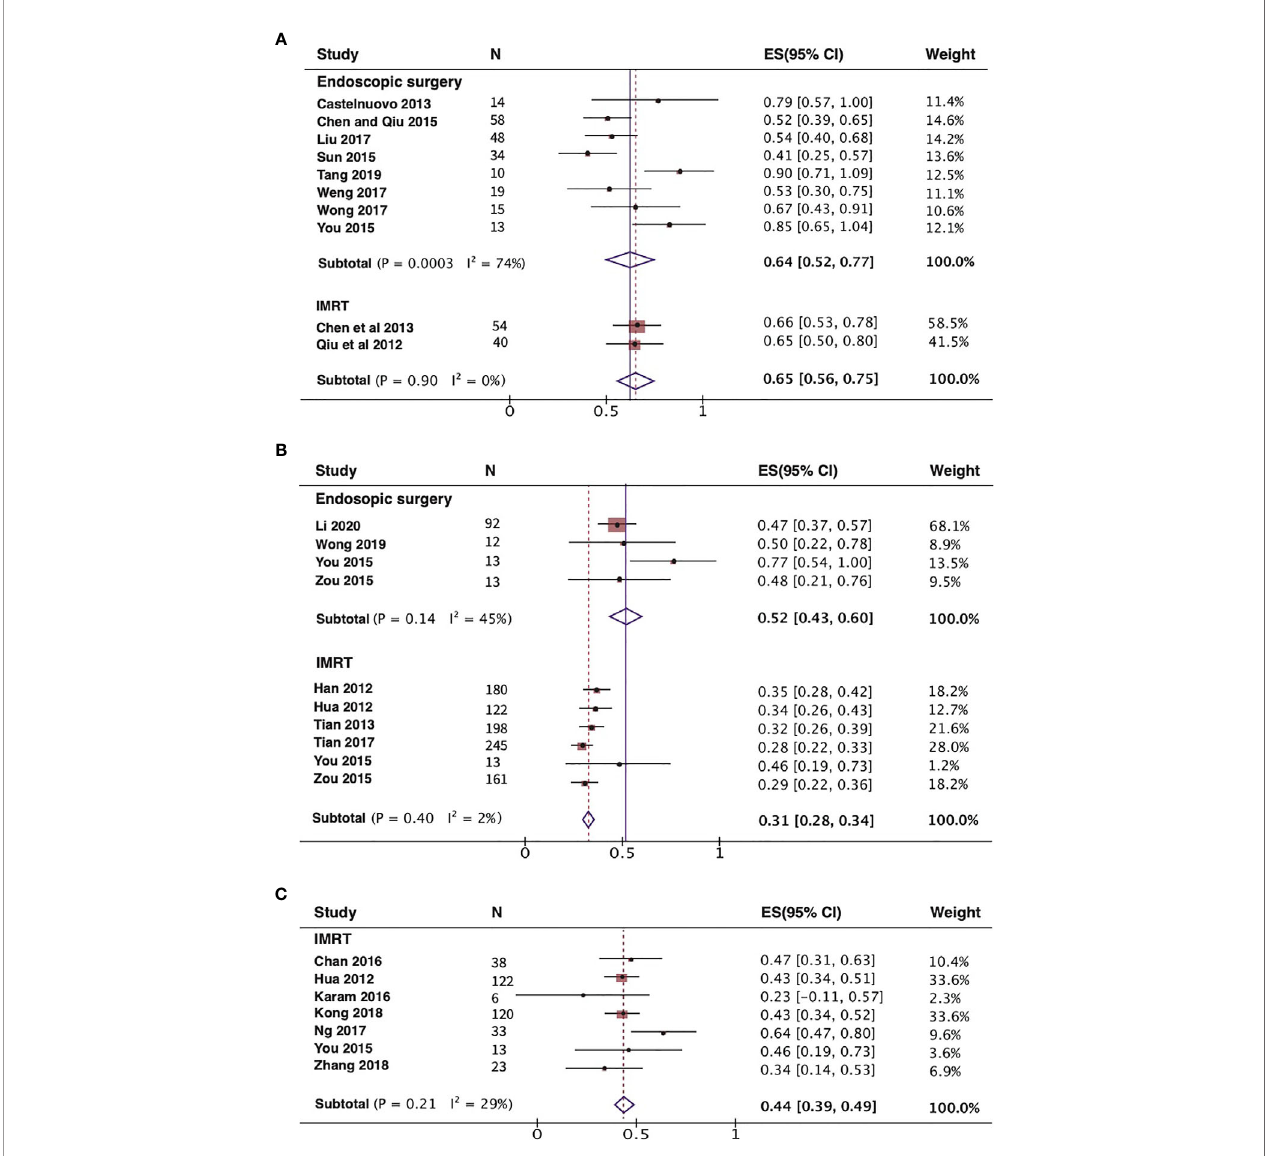
FIGURE 2 | Forest plot displaying the meta-analysis of OS in the endoscopic surgery and IMRT group with recurrent rT3-4 NPC. (A) Meta-analysis of 2-year OS rates. (B) Meta-analysis of 5-year OS rates. (C) Meta-analysis of 3-year OS rates for IMRT group. NPC, nasopharyngeal carcinoma; IMRT, intensity-modulated radiotherapy; OS, overall